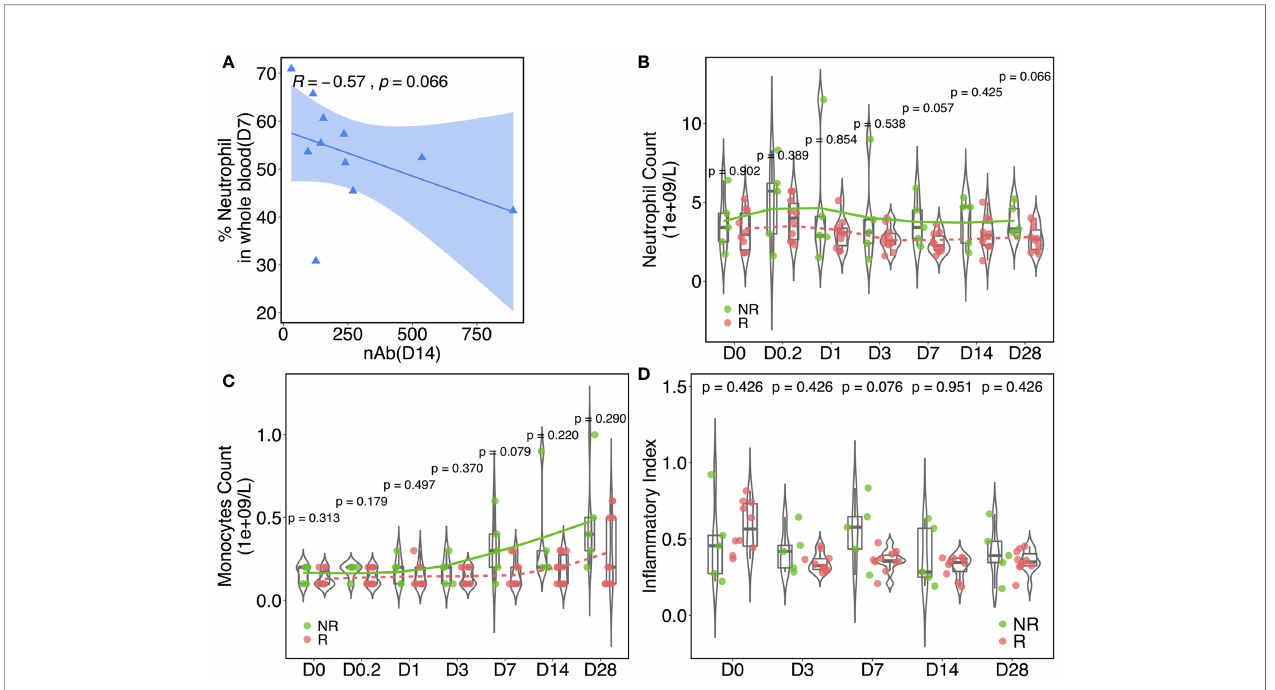
FIGURE 6 | In fl ammatory responses are associated with the neutralizing antibody (nAb) response. (A) Spearman ’ s correlation between the nAb titer (day 14) and the neutrophil percentage (day 7) in whole blood. The data plotted are from responders. The blue shaded area indicates the con fi dence interval of the trend line. Kinetics of the percentage of neutrophils (B) and monocytes (C) in whole blood at baseline and at different time points post-vaccination in responders (Rs) and in non-responders (NRs). (D) In fl ammation index values in NRs and Rs at different time points pre/post-rTV/HIV-1 (recombinant Tiantan vaccinia-based HIV-1 vaccine) vaccination. The index was calculated according to 27 pre-identi fi ed signature genes that are involved in in fl ammation pathways. For all, p -values were calculated using the Wilcoxon